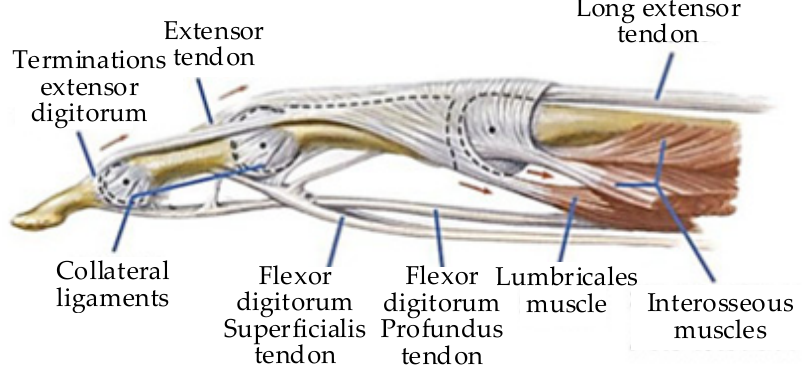
Figure 7. Finger anatomy [32].